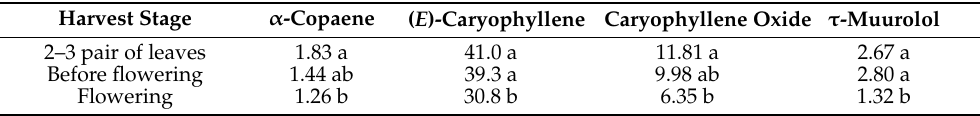
Table 1. Mean concentration (%) of α -copaene, ( E )-caryophyllene, caryophyllene oxide, and τ - muurolol obtained from the three levels of harvest stage where the effect of Harvest stage is significant. Harvest Stage α -Copaene